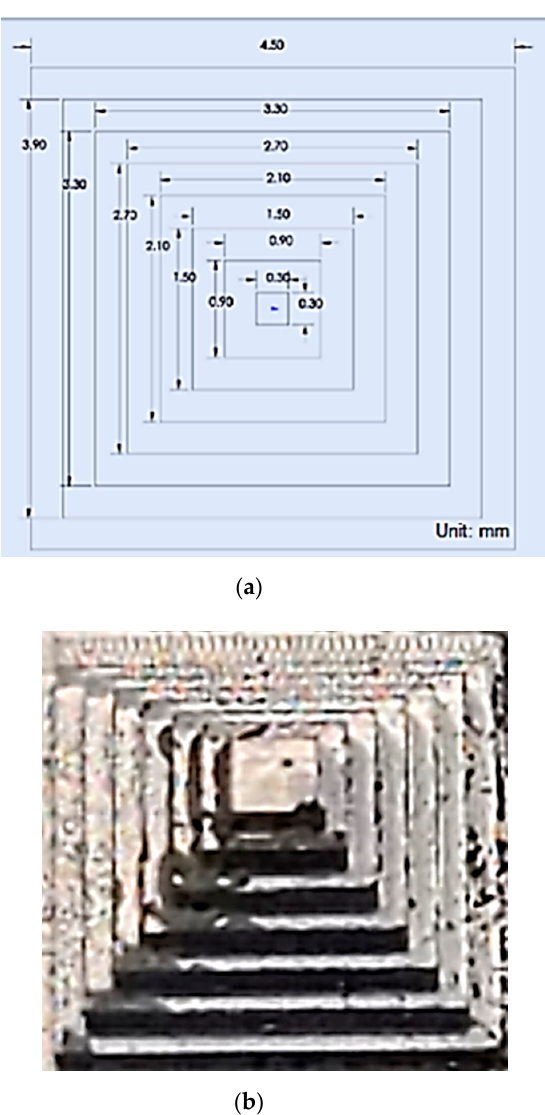
Figure 17. Micro-pyramid structure. ( a ) Micro-pyramid CAD design and ( b ) manufactured micro- Figure17. Micro-pyramidstructure. ( a )Micro-pyramidCADdesignand( b )manufacturedmicro-pyramid. Sensors 2020 , 20 , x FOR PEER REVIEW pyramid.